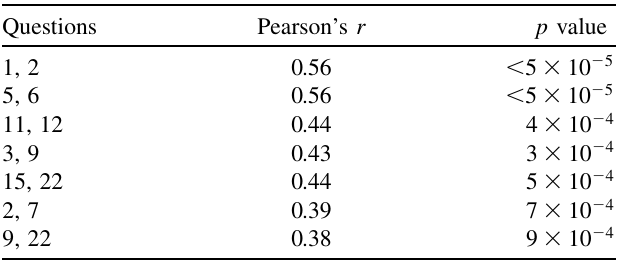
TABLE III. Post-test correlations between questions statisti- cally significant at the p (cid:2) 10 (cid:1) 3 level. The Pearson’s r correla- tion is calculated using Eq. (6). The p values were obtained from 20 000 Monte Carlo samples for each question pair with zero correlations between